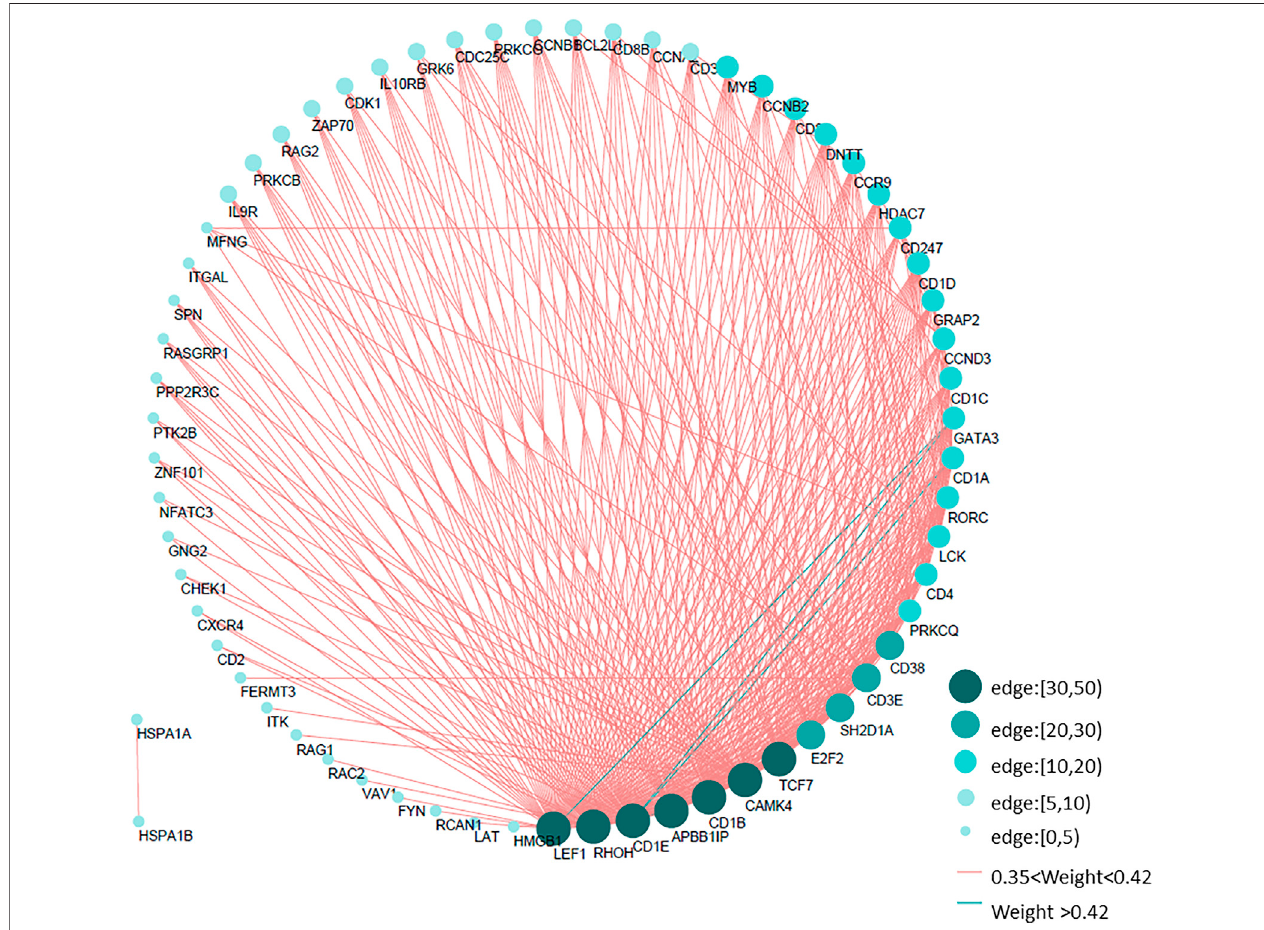
FIGURE4| Immunegeneinteractionnetworkofthymoma.AccordingtothegeneinteractiontableobtainedbyWGCNA,theedgeswithaweightgreaterthan0.35 in fi ve modules are selected to draw the immune network of thymoma. The size of the circle and the depth of the color indicate the different number of edges, cf. Table 3.XLSX of the Supplementary Material